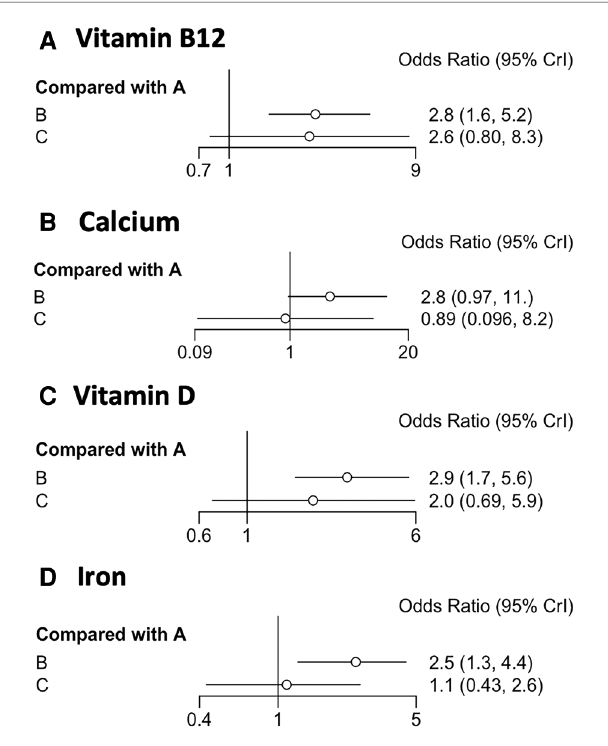
FIGURE 3 ( A – D ) Forest plots depicting OR values and 95% con fi dence intervals (CrI) for comparisons between operative BC and A. A refers to LSG, B refers to RYGB, and C refers to